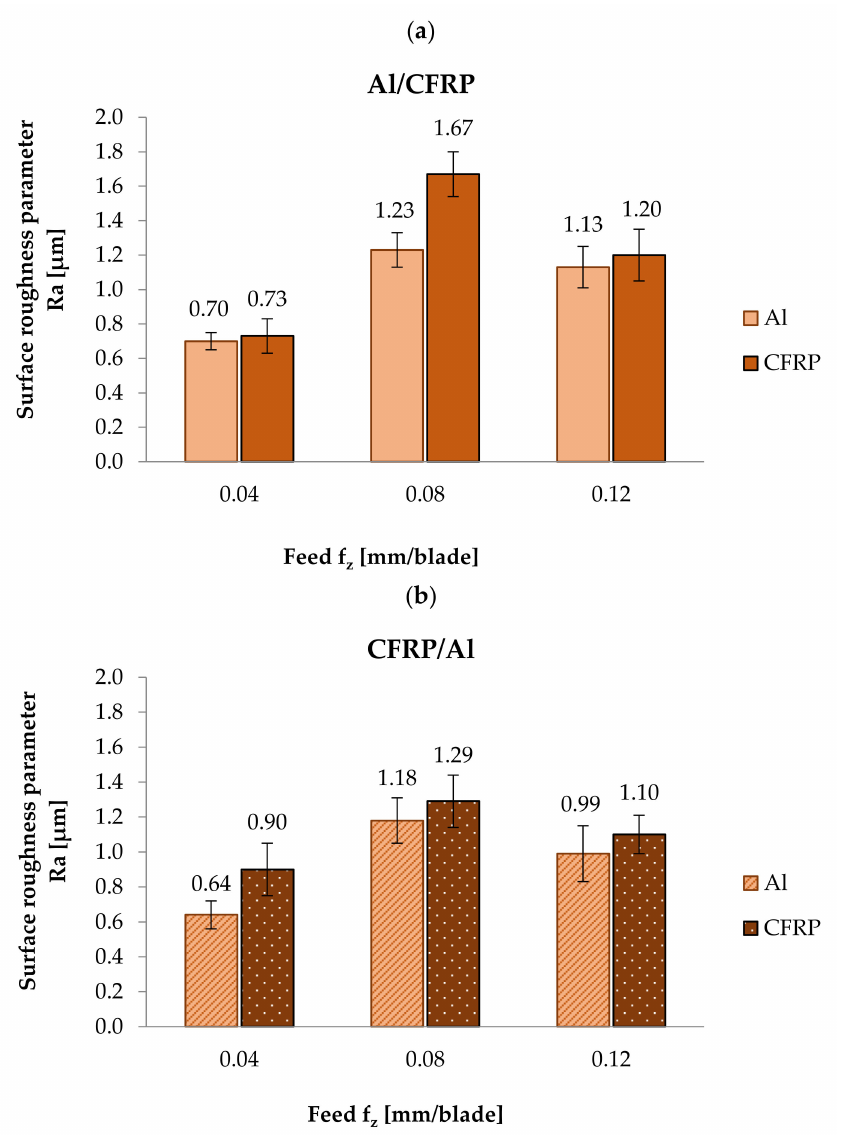
Figure 5. Ra parameter measurement results after milling: ( a ) using Al/CFRP strategy, ( b ) using CFRP/Al